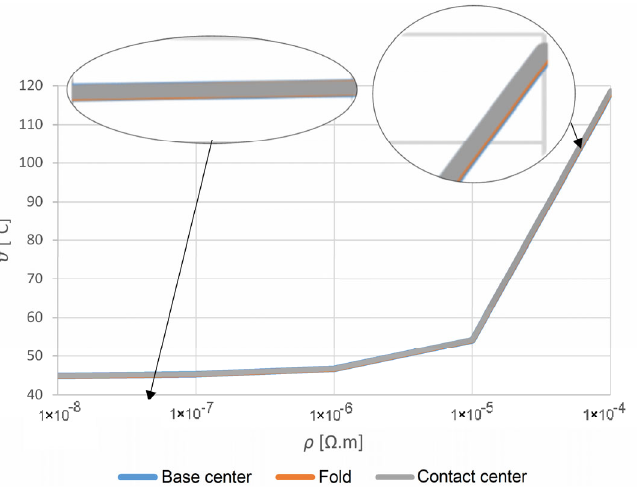
Figure 8. Dependence of impurity resistivity on temperature for high ‐ current copper contacts (for placements: base center, fold, contact center).